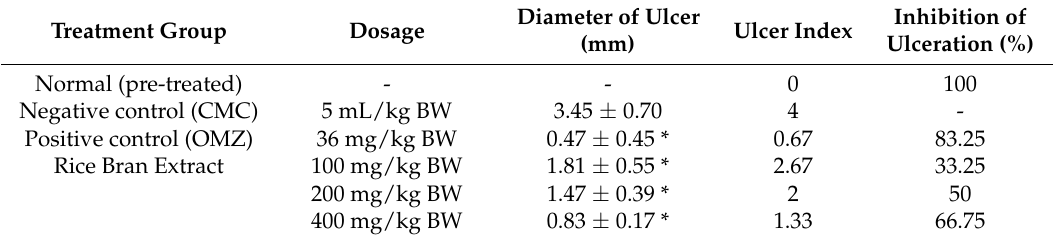
Figure 2. The gastric surface of organs in rat models: K-1, Normal Group; K-2, Negative Control Group (CMC); K-3, Positive Control Group (OMZ); K-4, Rice Bran Extract Group 100 mg/kg BW; K-5, Rice Bran Extract Group 200 mg/kg BW; and K-6, Rice Bran Extract Group 400 mg/kg BW. Blue arrows indicate ulcers. Table 1. The effect of rice bran extract on gastric lesions induced by ethanol.